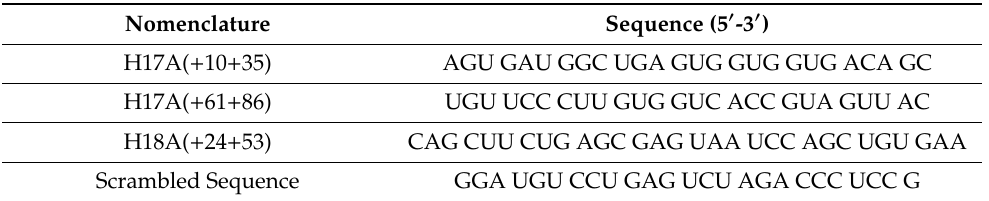
Table 1. Nucleotide sequences and annealing coordinates of AOs designed to remove dystrophin exons 17 and